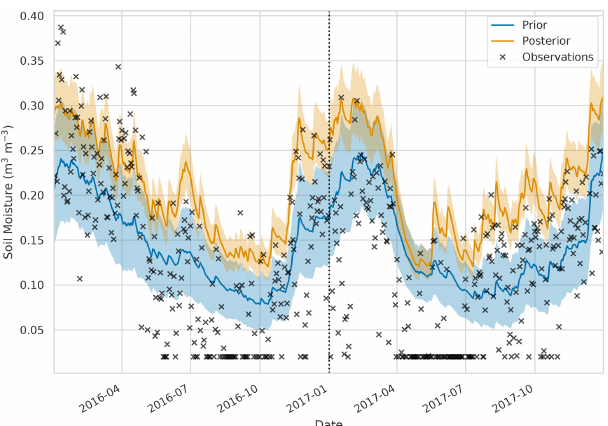
Figure 9. Time series of soil moisture for 51.81 ◦ N 0.17 ◦ W. Black crosses: SMAP observations, blue line and shading: prior JULES mean and ensemble spread, orange line and shading: posterior en- semble mean and spread. The dotted black line represents the end of the assimilation window and start of the hindcast period.